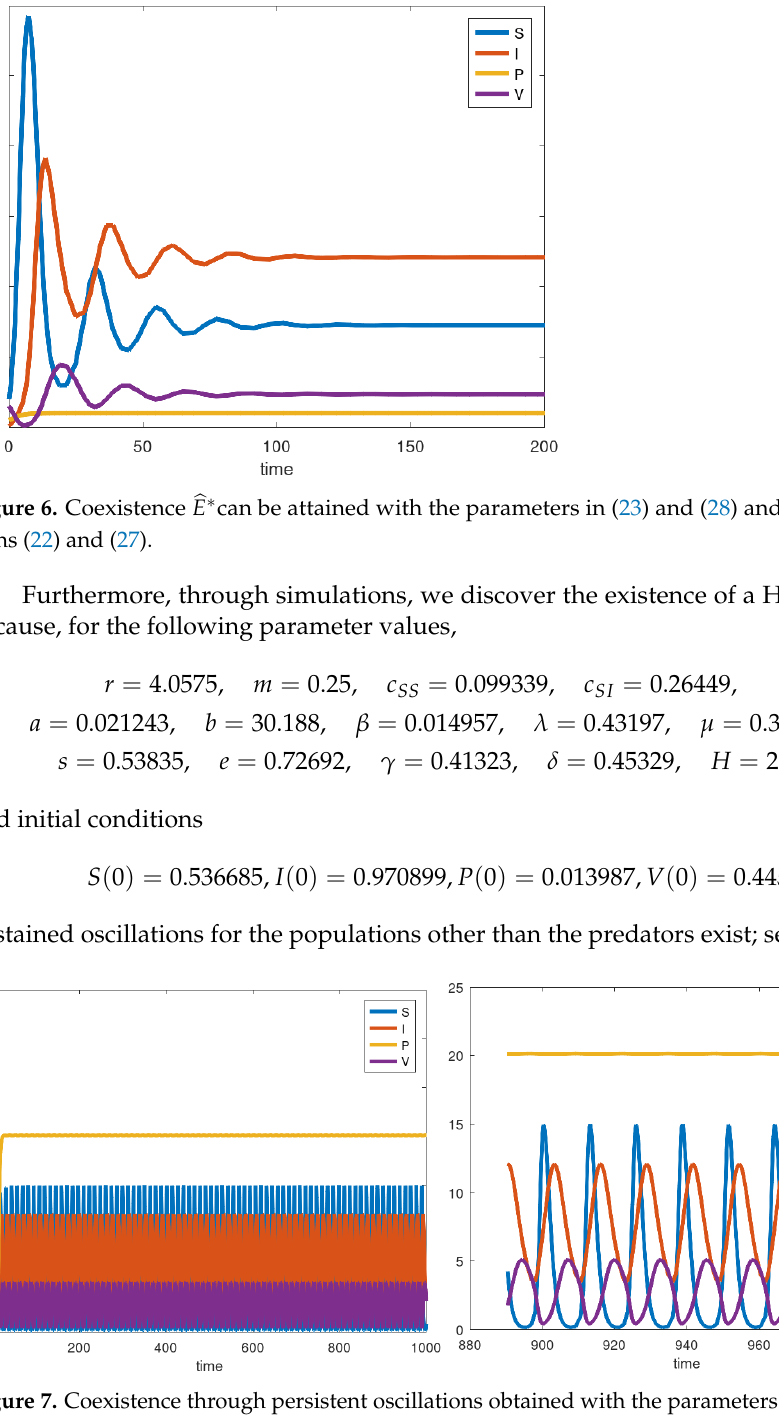
Figure 7. Coexistence through persistent oscillations obtained with the parameters in (29) and initial conditions (30). Left : the whole time series. Right : the tail of the